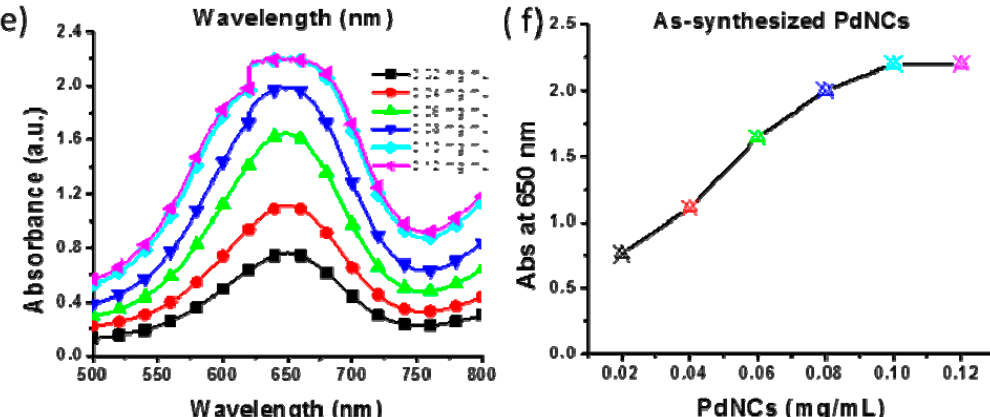
Figure 6. E ff ect of the nanocluster concentration: ( a ) Cuvettes showing the e ff ect of the nanocluster concentration on the color intensity; ( b ) Scanning electron microscopy (SEM) micrograph of freeze-dried nanoclusters; ( c ) Absorbance spectra for various concentrations of as-synthesized PdNCs; ( d ) Triplicate experiments performed on the e ff ect of varying the concentration of as-synthesized nanoclusters to produce error bars representing the standard deviations; ( e ) Absorbance spectra at various concentrations of freeze-dried nanoclusters; ( f ) Absorbance at 650 nm for assays having various concentrations of freeze-dried nanoclusters.